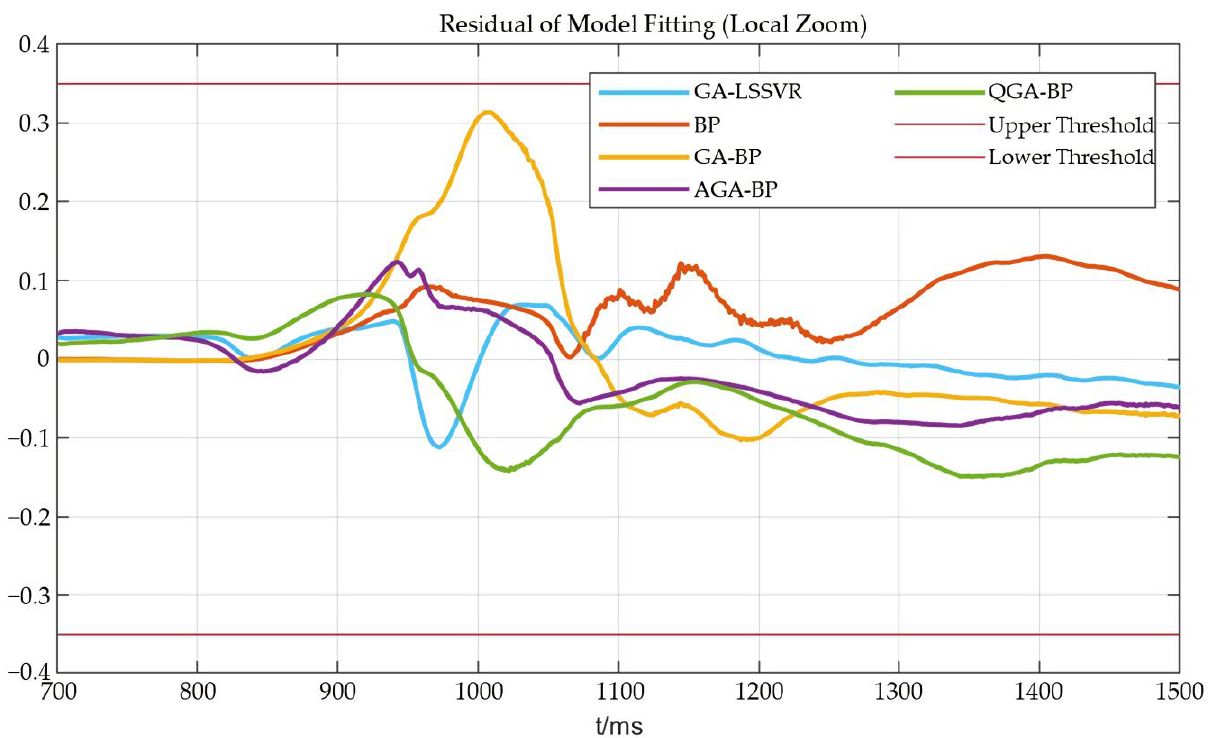
Figure 12. Fault test detection (Figure 9) local amplification (700 – 1500).